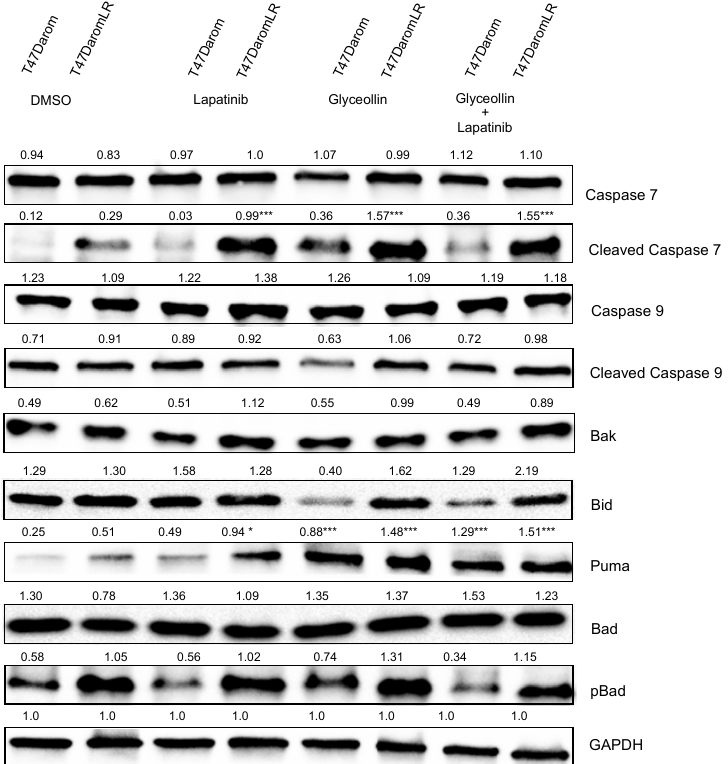
Figure 7. Western blot analysis for apoptosis ‐ related proteins. T47Darom and T47DaromLR cells were exposed to DMSO, 0.5 μ M lapatinib, 10 μ M glyceollin, and 0.5 μ M lapatinib in combination with 10 μ M glyceollin for 24 h, and GAPDH was used as the loading control. Densitometry values are indicated above each band, and the treatments were compared to DMSO control for the respec ‐ tive cell lines and normalized to GAPDH loading control. Student’s t ‐ tests were performed, and results are expressed as the mean (*** p < 0.001, ** p < 0.01, * p < 0.05) of a minimum of three independent experiments in